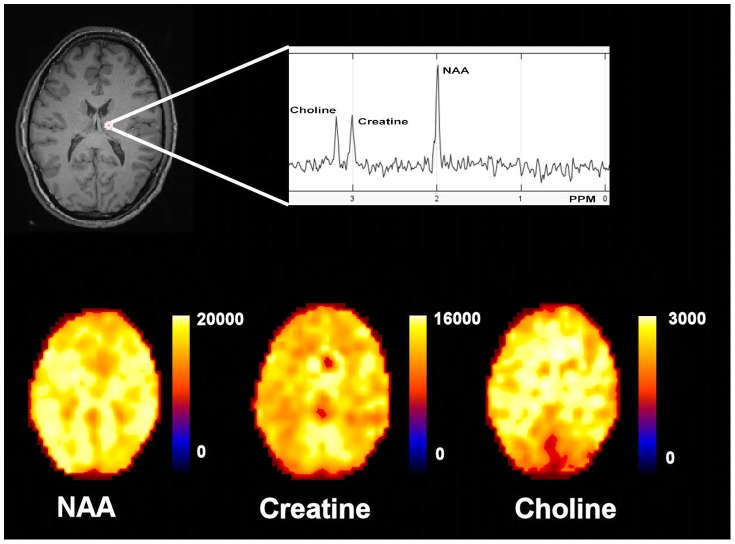
Metabolite parametric maps.T1 weighted magnetic resonance image in MNI152 space (2mm resolution) with a representative spectra from the right thalamus and N-acetyl aspartate (NAA), Creatine (Cr) and Choline (Cho) signal-intensity normalised metabolite concentration parametric maps. PPM (parts per million).